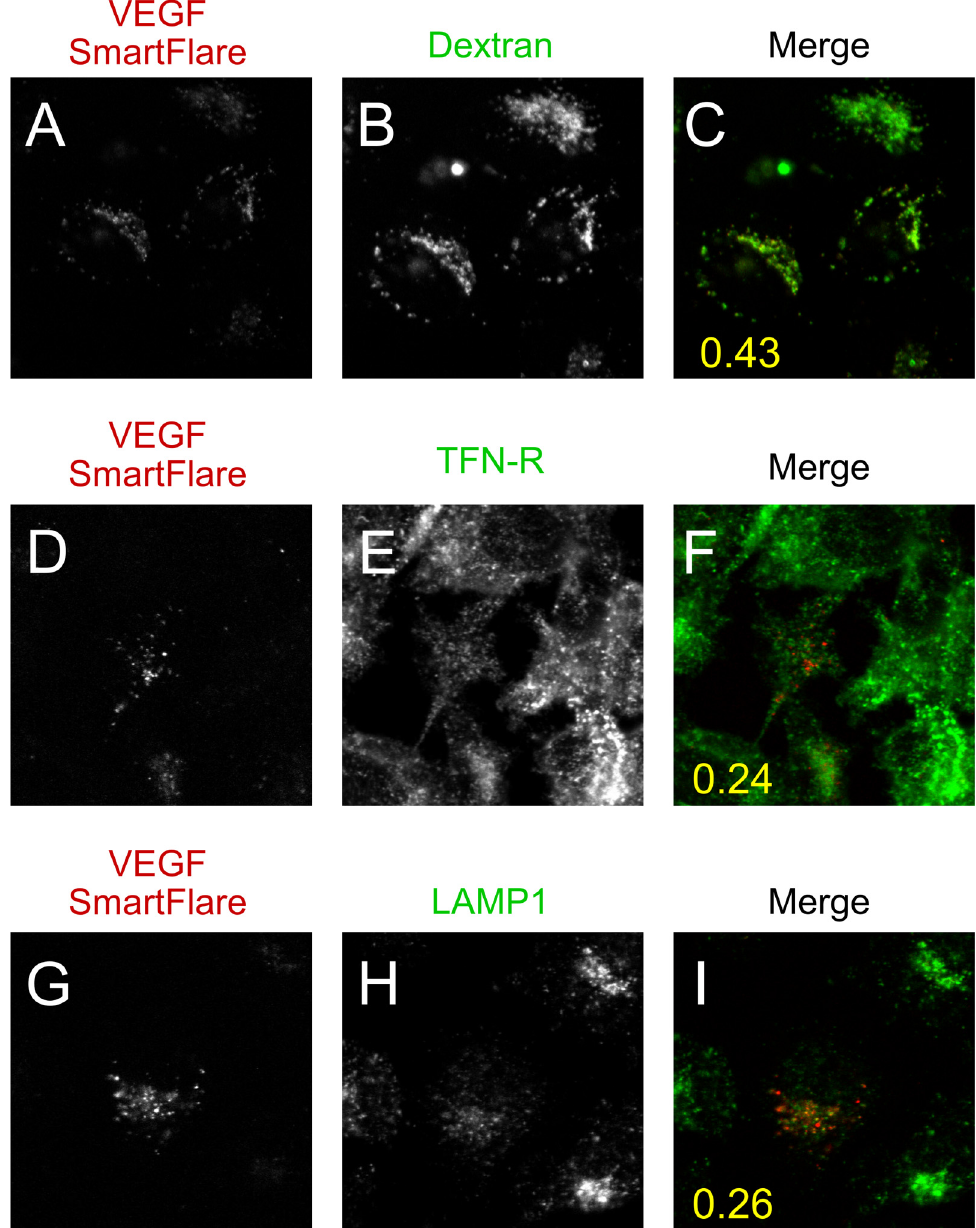
Figure 4. Studying the localisation of SmartFlares: HeLa cells were loaded with the VEGF SmartFlares in combination with a fl uorescent 10 kDa dextran to label fl uid-phase endocytic pathways (A – C). After fi xation, samples were immunostained either for the Transferrin Receptor (TFN-R: D-F) or Lysosome-associated Membrane Protein 1 (LAMP1: G – I) to demark the recycling and lysosomal compartments respectively. Shown are SmartFlare fl uorescence (A,D,G) and dextran or secondary antibody fl uorescence (B,E,H). Panels (C,F,I) show an overlay of the two channels (SmartFlares pseudo-coloured red) with the mean Manders ’ coef fi cient (yellow number) expressing the proportion of SmartFlare Signal overlapping with the respective marker for all fi elds